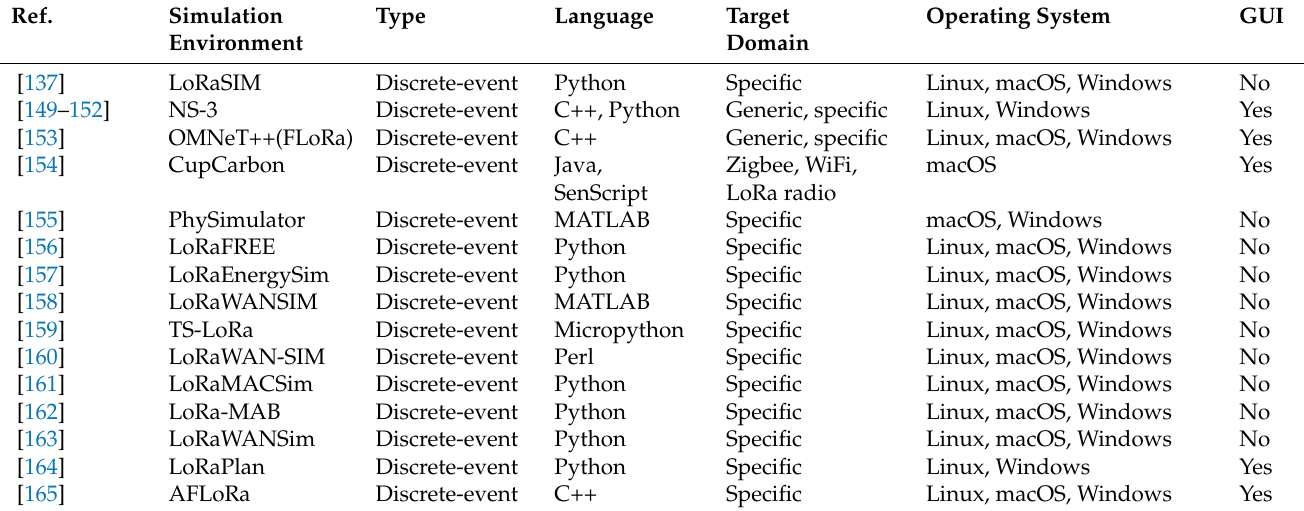
Table 8. Comparison of LoRa/LoRaWAN Simulators for IoT.